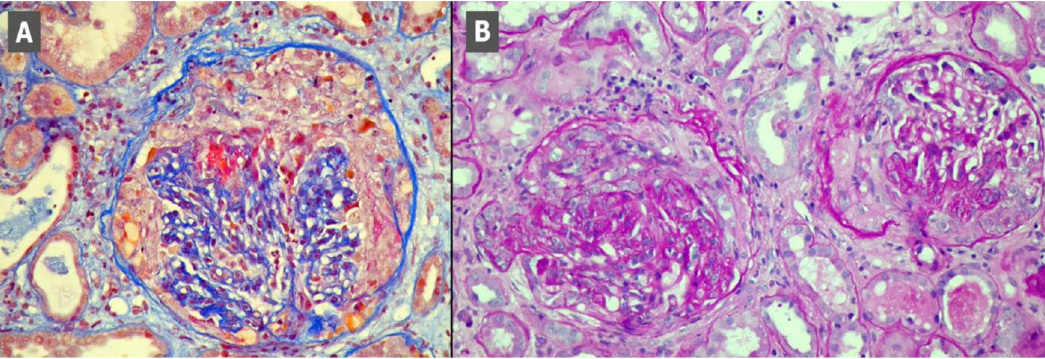
Figure 2. Kidney biopsy scans. Scan A - segmental necrosis and cellular crescent, Masson stain. Scan B - Glomeruli with fibrocellular crescents, PAS